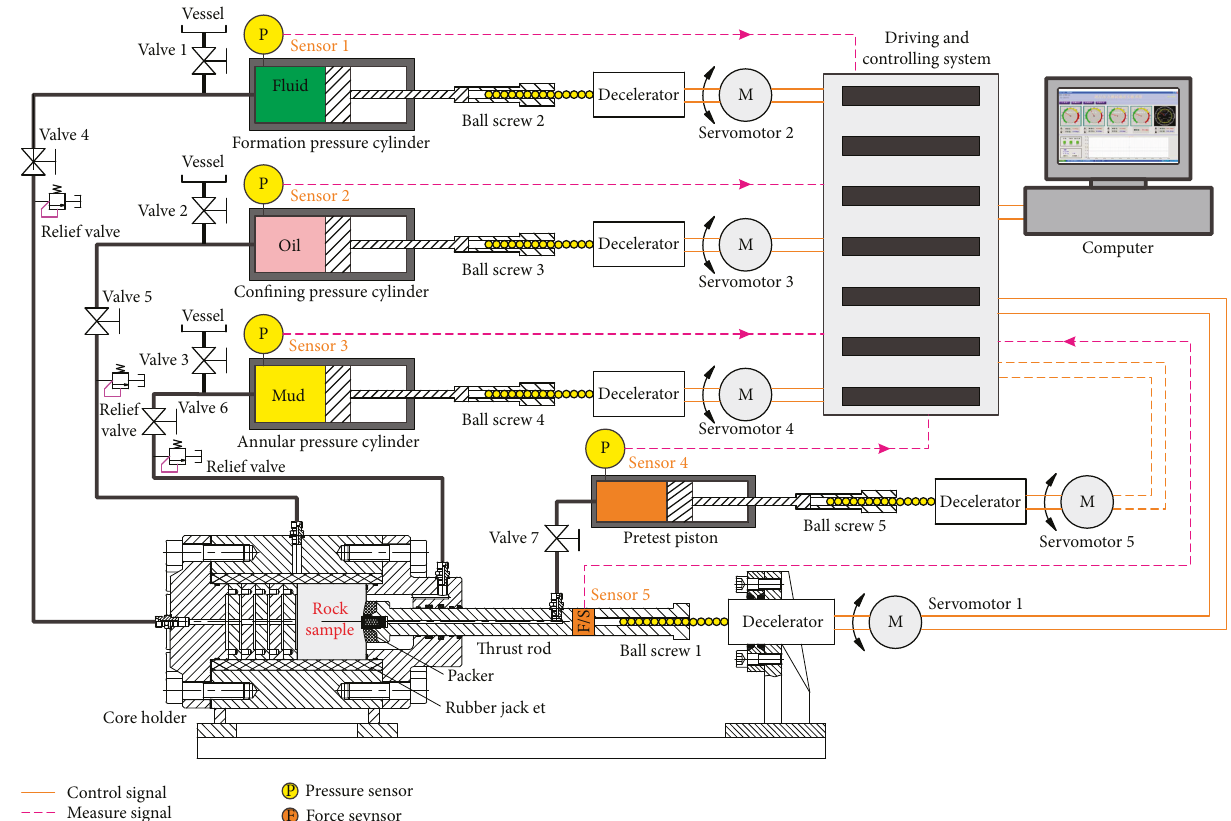
Figure 3: Schematic of the physical simulation system for